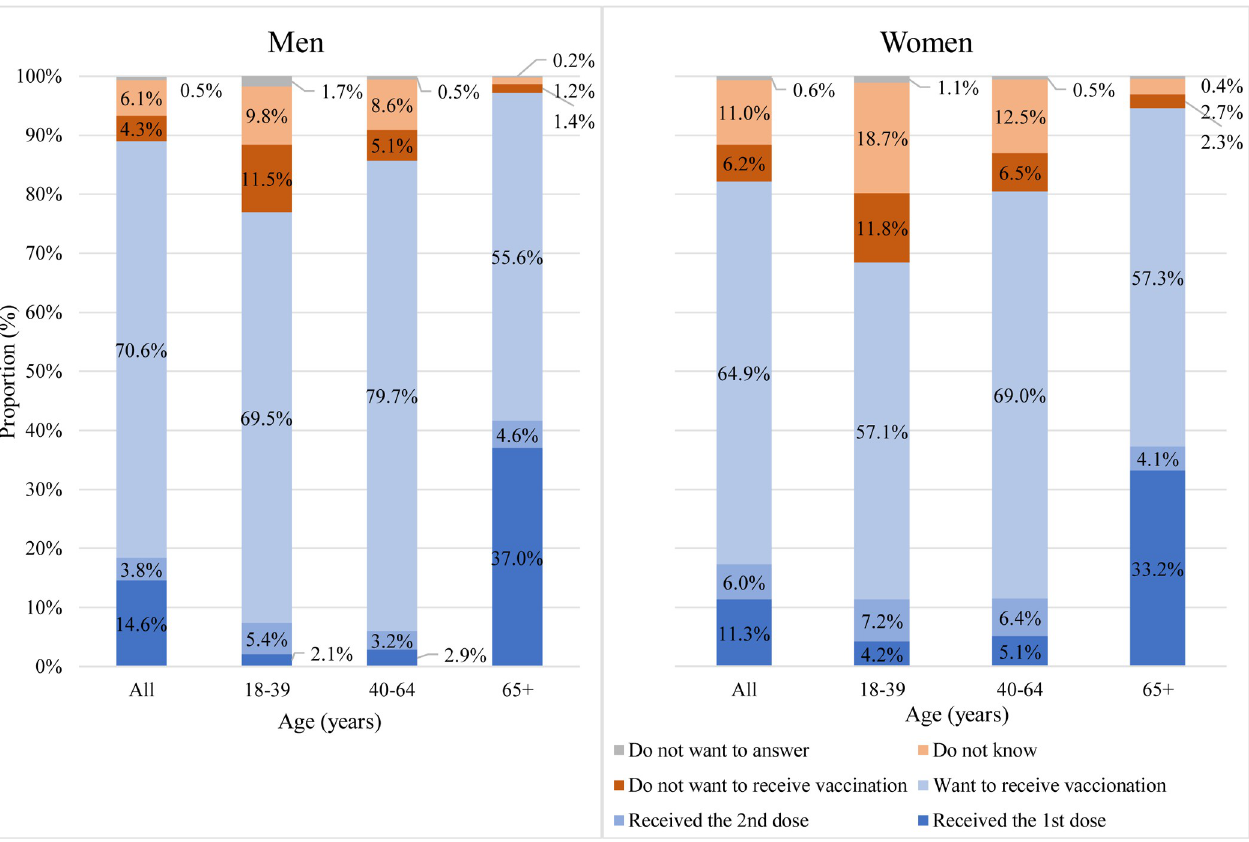
Fig 1. Public attitudes toward COVID-19 vaccination, Osaka, Japan, June 2021. Note: Data collection was conducted during June 1–20, 2021 with residents of Osaka prefecture aged � 18 years (n = 23,214; 8,482 men & 14,732 women) through the smartphone health app “ Asmile ”. Respondents were asked “Free-of- charge COVID-19 vaccine rollout has started. Have you already received the vaccine? If not, do you want to receive it?”.